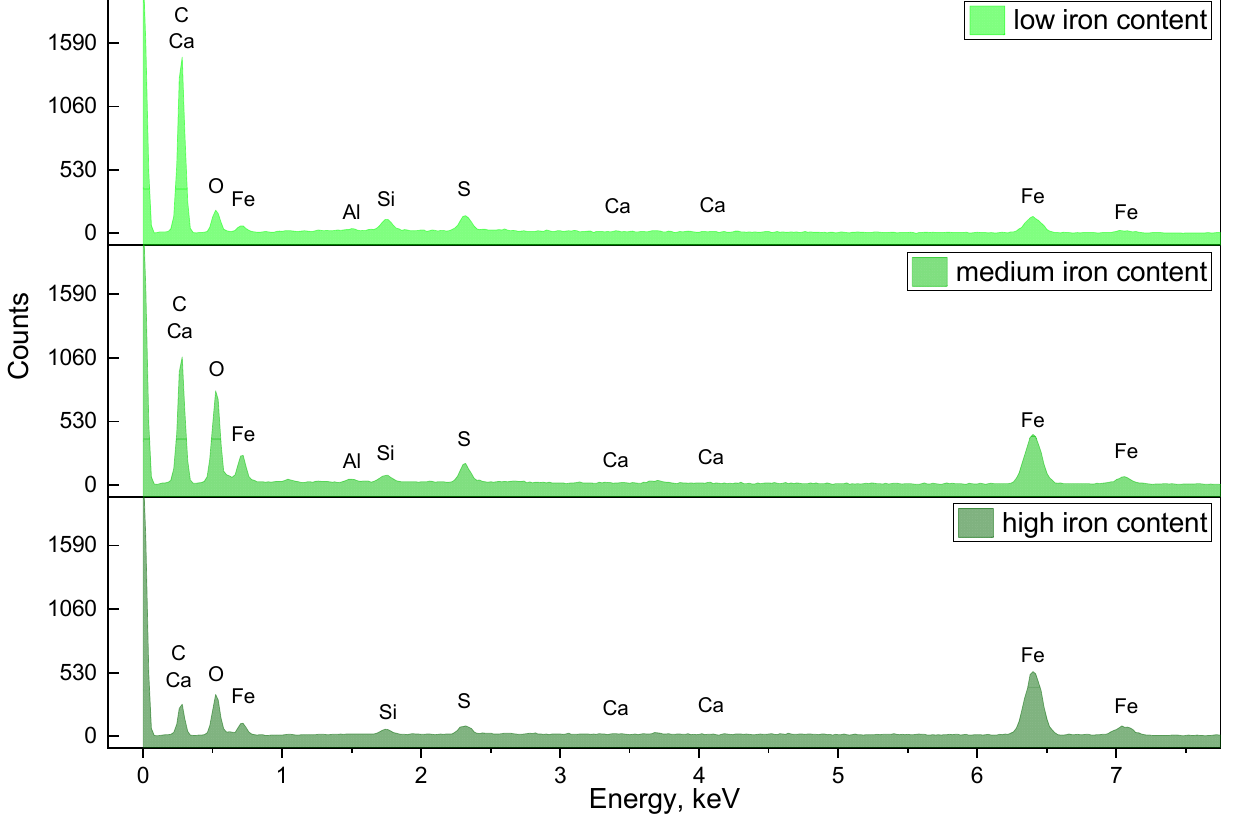
Figure 1. The EDX spectra for the points with low, medium and high iron content.